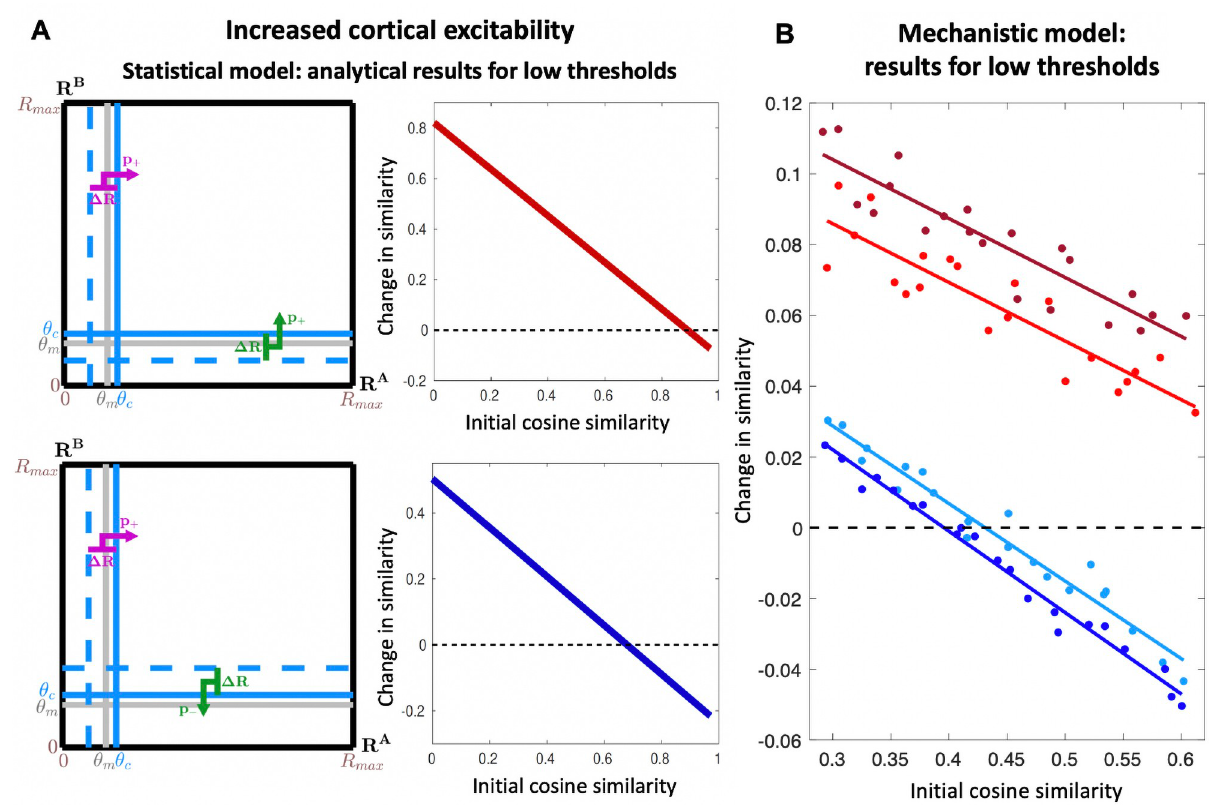
Fig 5. The mechanism for pattern convergence and divergence requires a high-threshold transfer function. Predicted trends in pattern convergence and divergence for increased cortical excitability, obtained from the statistical model and the mechanistic model with low activation thresholds. Low cortical activation thresholds yield effects that are qualitatively different from the realistic high-threshold case. ( A ) Analytical results obtained for θ c = 0.35 and the feedback scenarios of Fig 2A and 2B: red indicates 100% excitatory feedback for both odors; blue indicates 100% is low, some modules that are not odor-responsive ( R < θ ) are pushed by excitatory/inhibitory feedback for the first/second odor, respectively. Since θ c m feedback above θ (sketches to left) changing similarity between cortical odor representations (right) differently from Fig 2A and 2B: correlated c feedback inputs (red) yield pattern convergence decreasing with increasing odor similarity, and for high odor similarity, pattern convergence can turn into pattern divergence. Anticorrelated feedback inputs (blue) yield pattern convergence/divergence for low/high initial odor similarity, respectively. ( B ) Similar results are obtained from the mechanistic model (same simulation conditions as in Fig